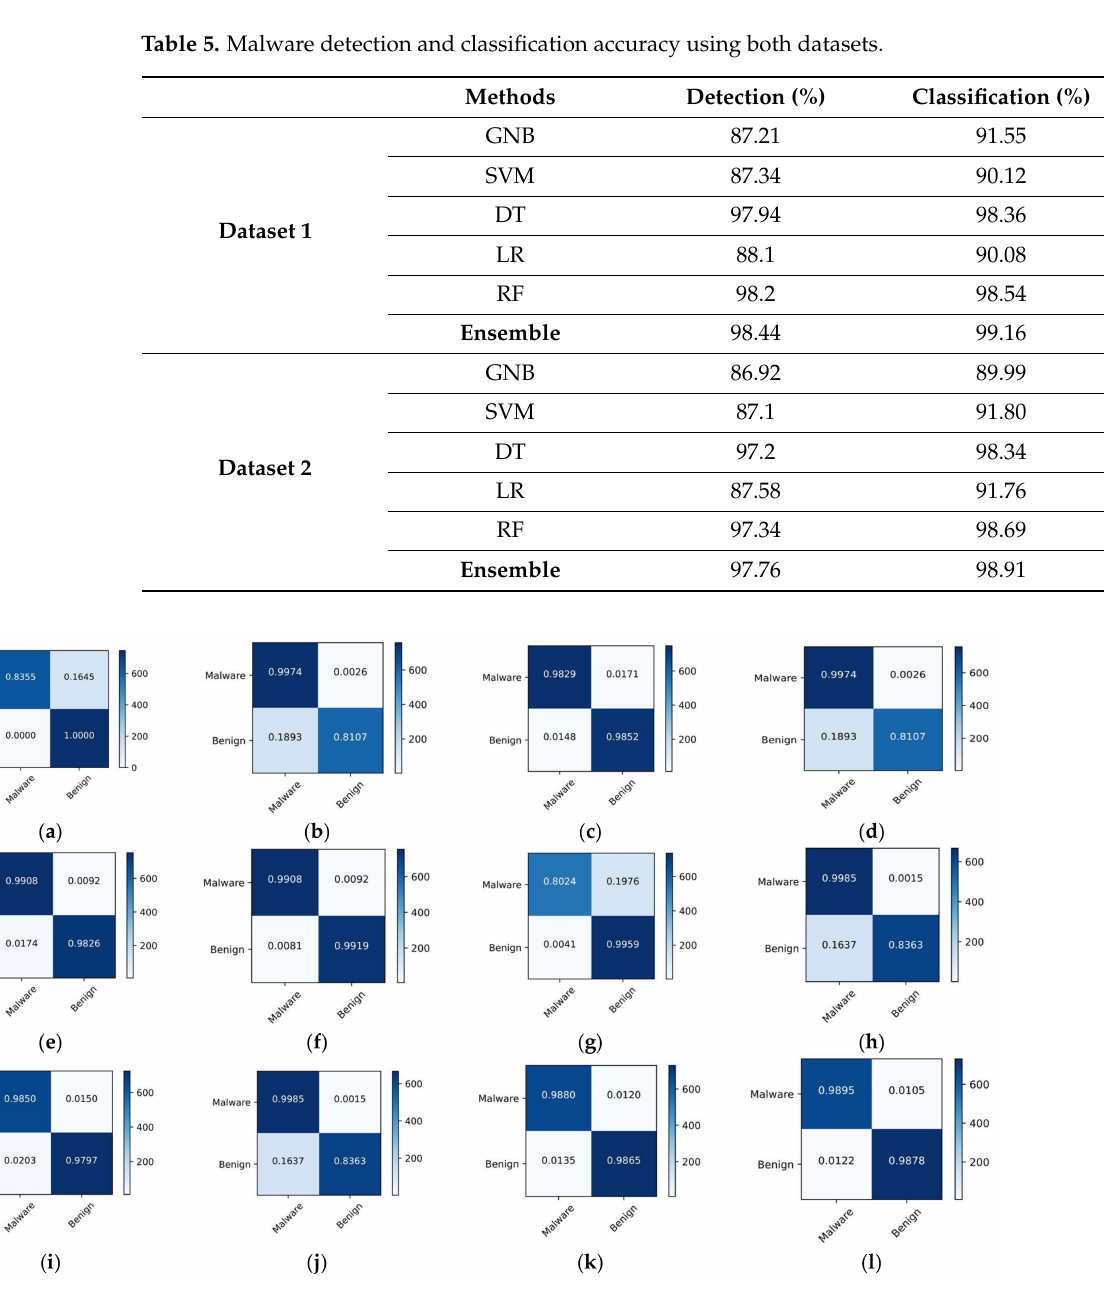
Figure 11. Confusion matrices for malware detection using both datasets: ( a ) GNB; ( b ) SVM; ( c ) DT; ( d ) LR; ( e ) RF; ( f ) Ensemble; ( g ) GNB; ( h ) SVM; ( i ) DT; ( j ) LR; ( k ) RF; ( l )